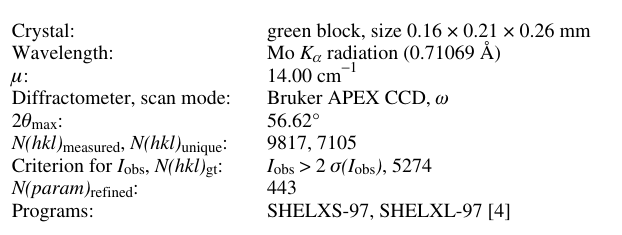
Table 1. Data collection and handling.